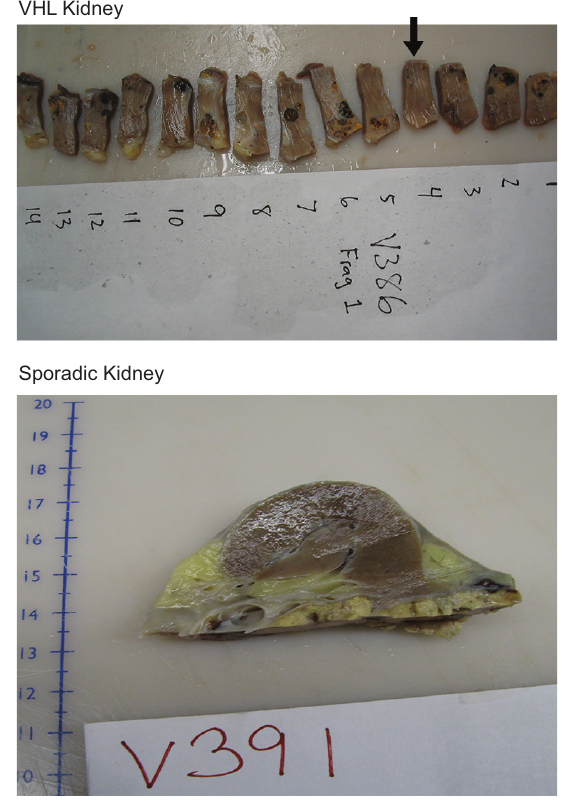
Figure 1: Example of VHL kidney cuboid, sectioned into consecutive tissue blocks (top); cystic structures or small tumor nodules are visible in most of the blocks; chosen tis- sue blocks of interest (BOI, arrow) show no or only mini- mal pathologic changes grossly; in contrast, sporadic kidney reveals no obvious pathologic changes in non-tumorous parenchyma